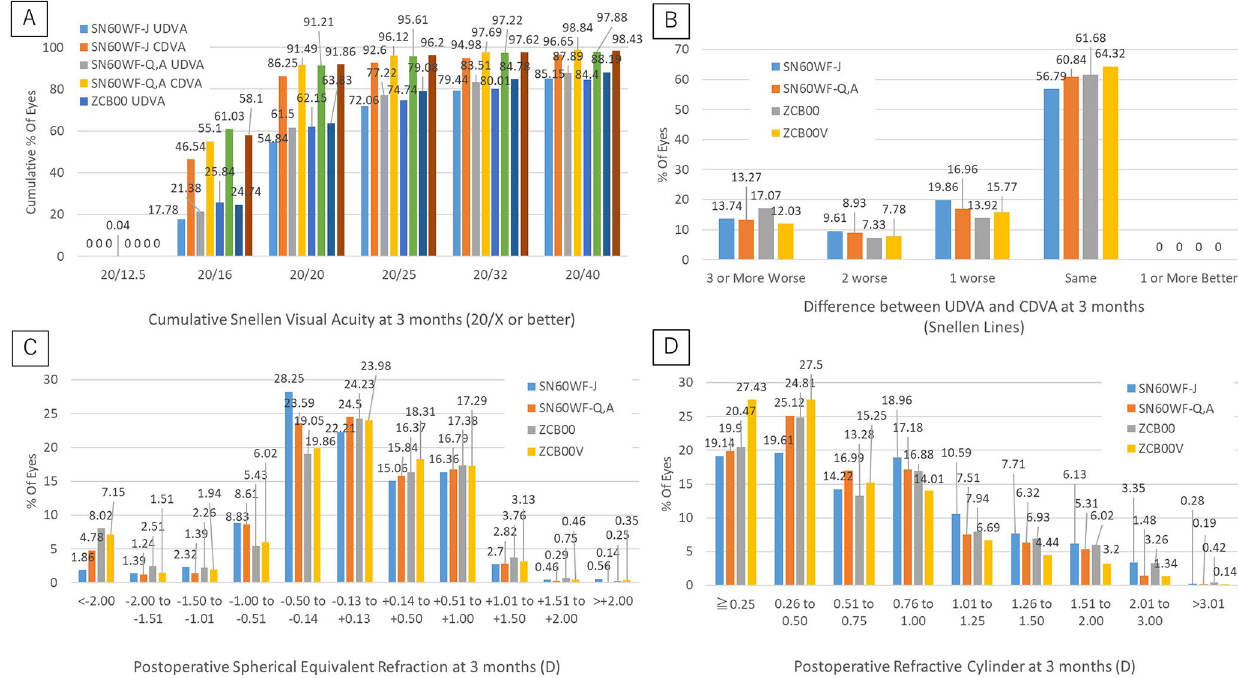
Figure 3. ( A ) Cumulative Snellen binocular acuity at 3 months (20/ × or better). ( B ) Difference between uncorrected (UDVA) and corrected (CDVA) distance visual acuity at 3 months (Snellen Lines). ( C ) Postoperative spherical equivalent (diopters (D)) at 3 months. ( D ) Refractive cylinder (D) at 3 months.